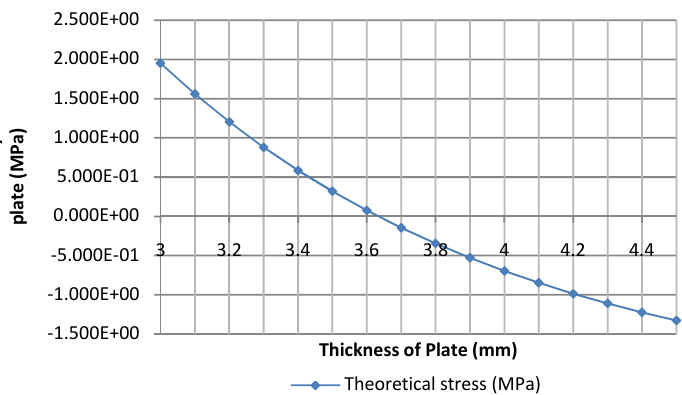
Fig.8 Theoretical predictions of stress in bone underlying a plate of changing